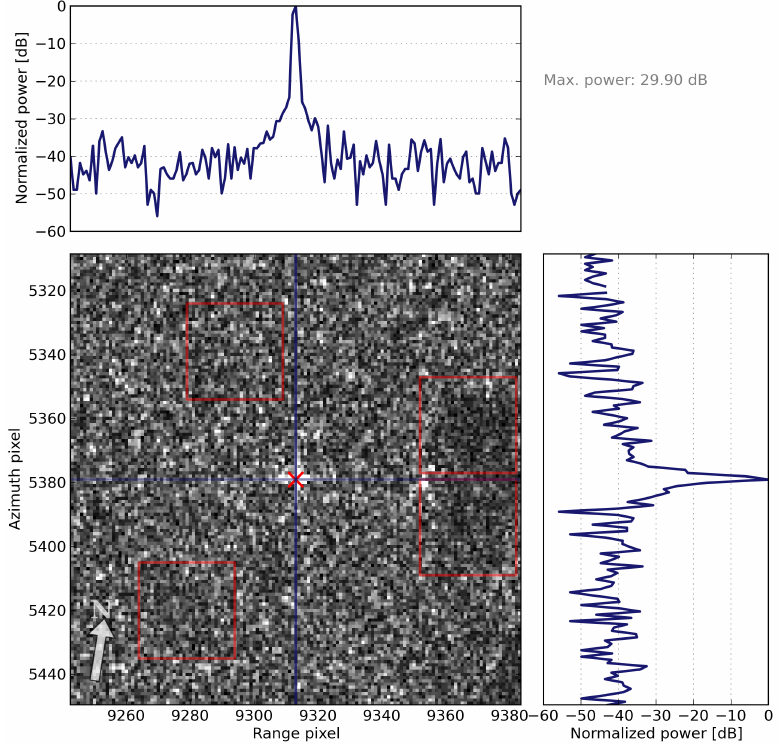
Figure 7. 1 . 5 corner impulse response at site D26 for the first overpass on 7 April 2013. Also see caption of Figure